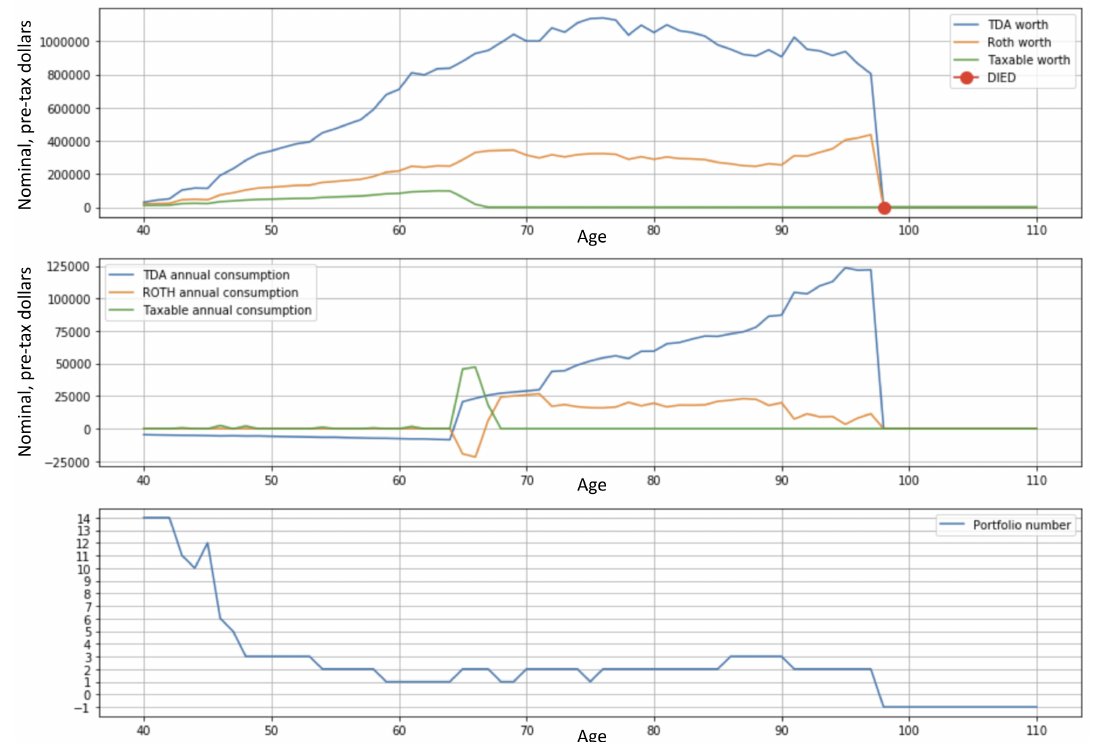
Figure 3. An example path for Investor #1 under the optimal strategy. Age is on the horizontal axis. For this example path, the investor was solvent when they died at age 98. In the top two panels, the dollar values on the vertical axes are in nominal, pre-tax dollars. Top panel: The wealth in the TDA, Roth, and taxable accounts over time. Middle panel: The annual consumption in the three accounts, where negative consumption corresponds to a contribution. Bottom panel: The optimal investment strategy over time, where portfolio 0 is the most conservative investment portfolio, portfolio 14 is the most aggressive investment portfolio, and “portfolio -1” is used to indicate the investor has passed